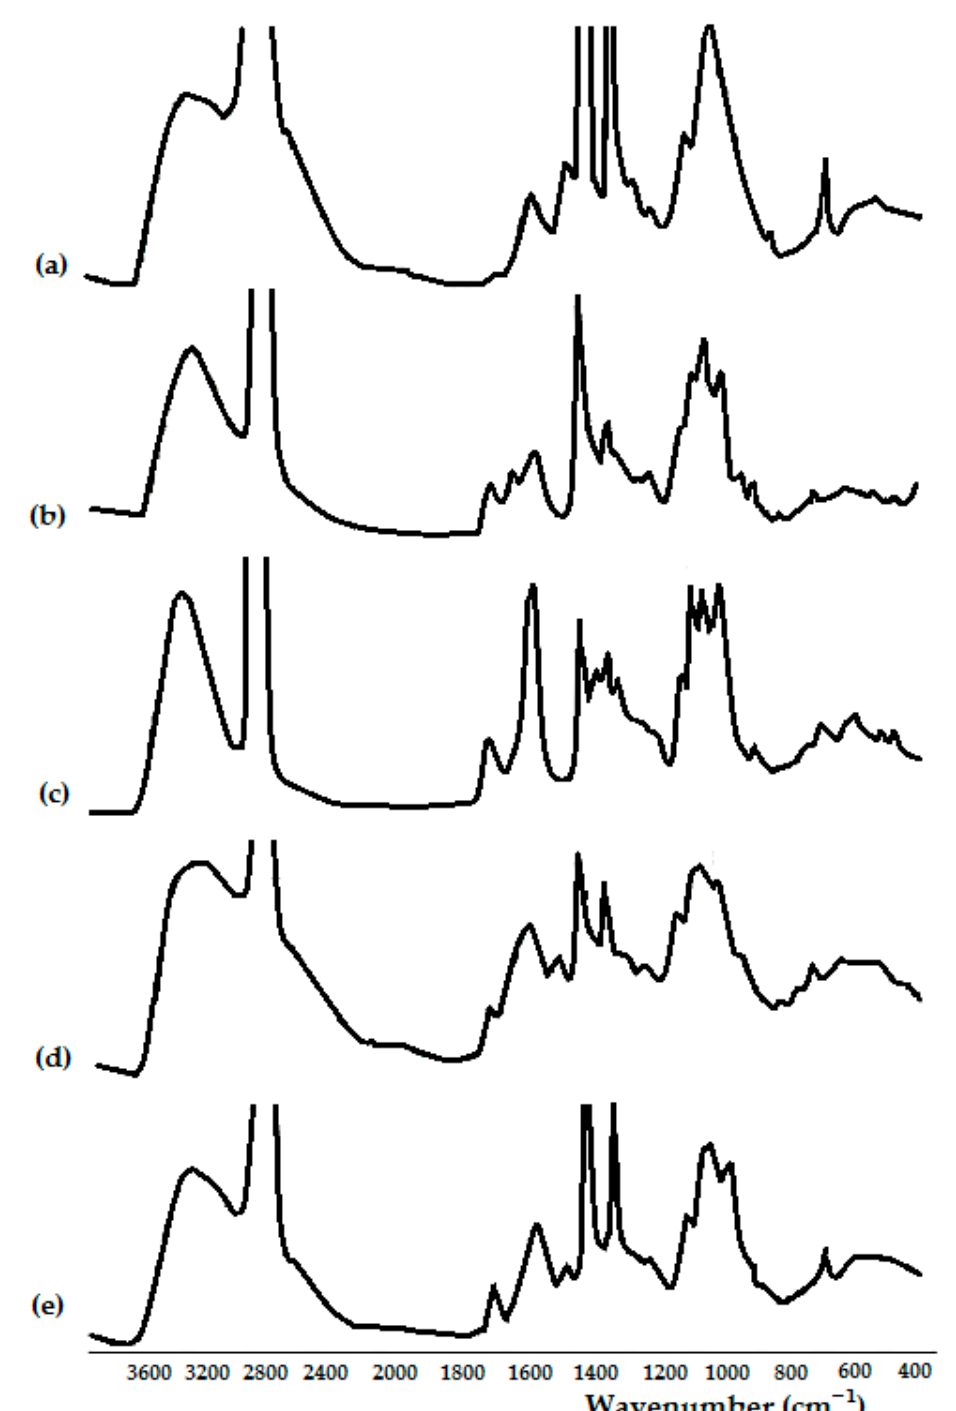
Figure 3. FT–IR spectra of ( a ) chitosan hydrochloride, ( b ) apple pectin, ( c ) citrus pectin, ( d ) chitosan hydrochloride/apple pectin 1:1 hydrogel, ( e ) chitosan hydrochloride/citrus pectin 1:1 hydrogel.